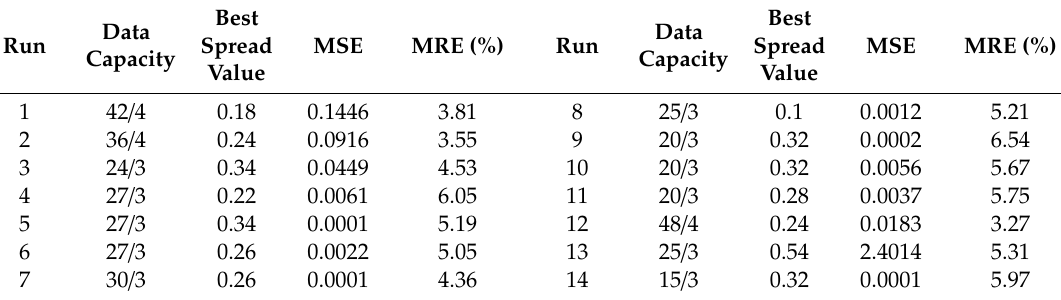
Figure 7. Verification results of prediction performance of GRNN model. Table 3. The prediction results of GRNN model based on K / S and dye-uptake